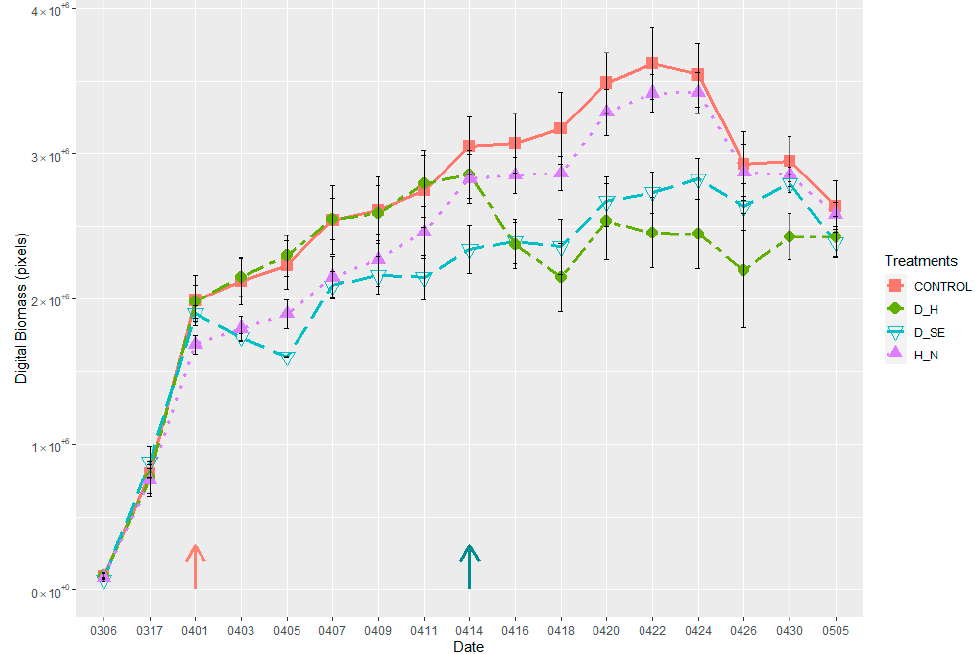
Figure 6. Plant growth pattern under different treatments, (control, drought at stem elongation (D_SE), drought at heading (D_H), and high nitrogen content (H_N)), from sowing to grain devel- opment. Pink arrow indicates when drought stress was induced, D_SE; dark cyan arrow indicates when drought stress was induced, D_H, and second nitrogen dosage was applied, H_N. The Y -axis represents the time points when the digital biomass was sampled and the X -axis represents the mean values of the obtained digital biomass. Error bars are standard error.